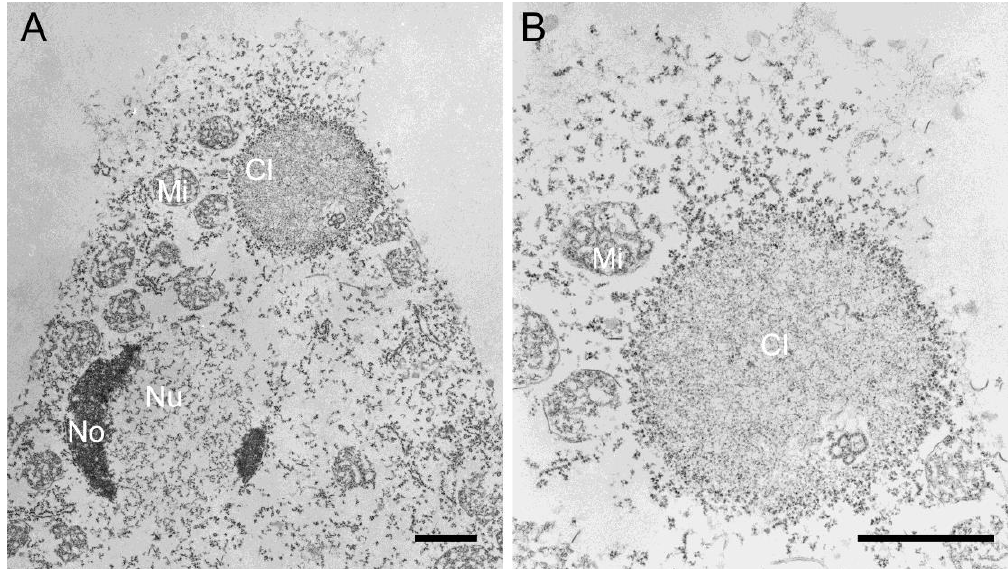
Figure 1. Filamentous structures at intranuclear membrane stacks obtained upon expression of FLAG- NE81 in Xenopus oocytes. ( A ) TEM image showing intranuclear membrane stacks elicited through FLAG-NE81 expression. ( B , C , C′ ) Field-emission (fe)SEM image showing Xenopus lamin B2 filaments ( B ) and Dictyostelium FLAG-NE81 filaments ( C , C′ ) associated with intranuclear membrane stacks. Scale bars = 100 nm.